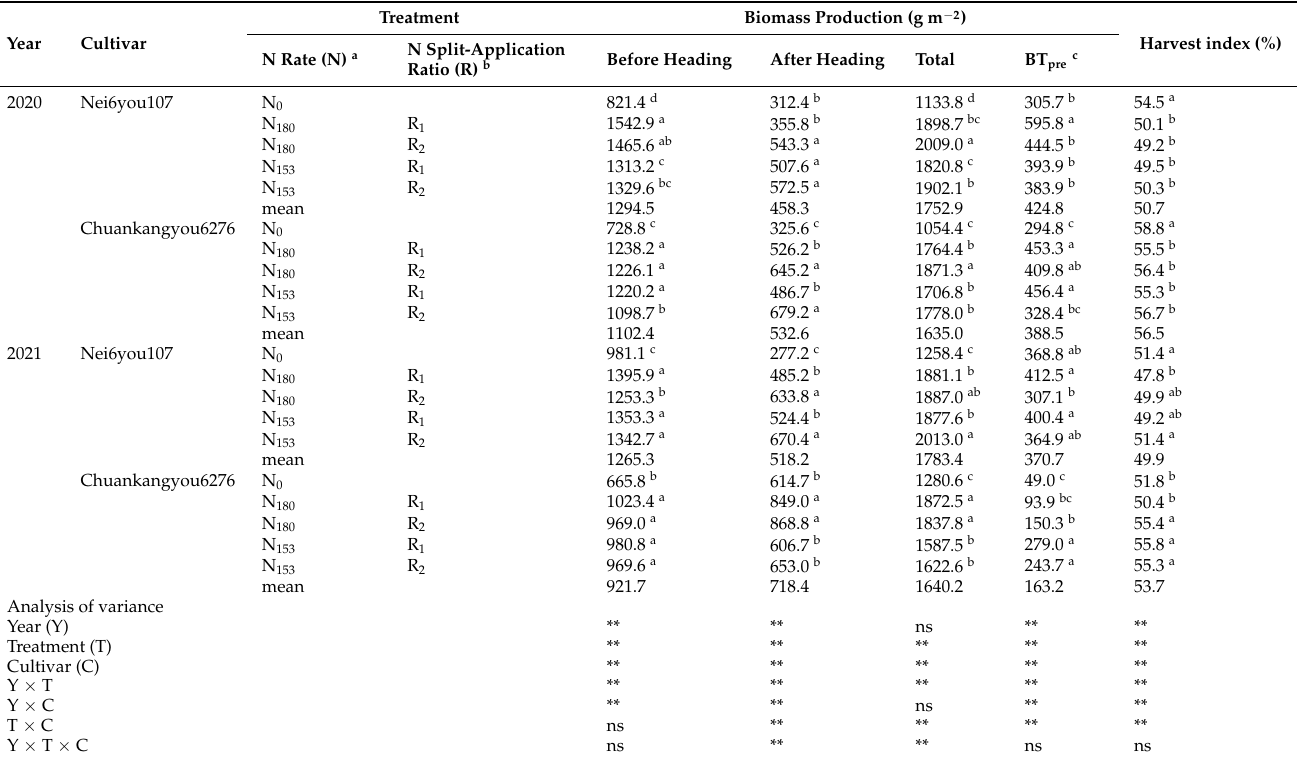
Table 4. Effect of different N management practices on biomass production, and harvest index (HI) of hybrid rice in the no-tillage, direct-seeded (NTDS) cropping